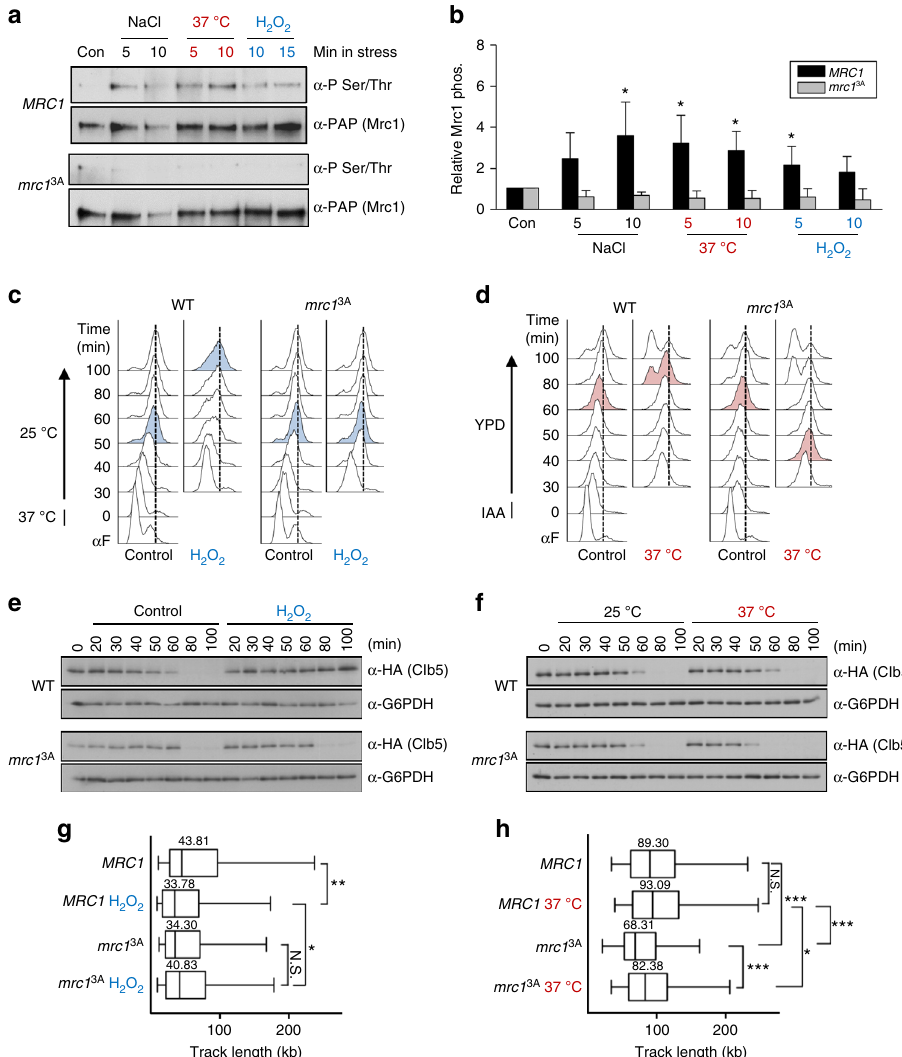
Fig. 1 Mrc1 is phosphorylated upon stress to delay DNA replication. a Mrc1 is phosphorylated upon osmotic, heat, and oxidative stresses and mrc1 3A protein suppresses this phosphorylation. Mrc1 – TAP and mrc1 3A – TAP protein were immunoprecipitated (IP) from cells subjected to several stresses and phosphorylation was assessed by western blotting using α -phospho Ser/Thr antibodies. Total Mrc1 – TAP protein levels were assessed using the anti-PAP antibody. Con control. b The graphs indicate the relative phosphorylation of Mrc1 and mrc1 3A (assessed as in a ) normalized to the total amount of precipitated Mrc1 – TAP protein and then referenced to the control conditions. The data represent the mean and standard deviation of three independent experiments. Values that are signi fi cantly different (respect to the control conditions) from Student's t test are indicated by asterisks (* p < 0.05). c , d Oxidative ( c ) and heat ( d ) stresses cause a delay in cell cycle progression that is abolished in the mrc1 3A cells. Cells were synchronized at the beginning of S phase as described (see “ Methods ” section) and released into S phase at 25 °C in YPD (control) or in the presence of oxidative ( c ) or heat stress ( d ). DNA replication was assessed using FACS. The vertical dotted lines indicate the end of S phase (2C peak) and the colored plots indicate the time point at which cells have reached the 2C peak. IAA indole acetic acid, α -F pheromone ( e , f ) mrc1 3A cells do not delay Clb5 degradation upon oxidative ( e ) or heat ( f ) stress, in contrast to wild-type cells. Cells were treated as in c and d and analyzed using western blotting. α -G6PDH, loading control. g , h Replication fork progression is slowed down upon stress. DNA from cells treated as in c and d was assessed by combing analysis of replication forks in WT and mrc1 3A cells in control conditions or upon oxidative and heat stresses, as indicated, after their release into S phase. The graphs indicate the distribution of BrdU track length (kb) upon oxidative and heat stress during 30 and 15 min of labeling, respectively. Box, 25 – 75 percentile range; Whiskers, 5 – 95 percentile range; *Values signi fi cantly different (* p < 0.05, ** p < 0.01) as determined by the Mann – Whitney U